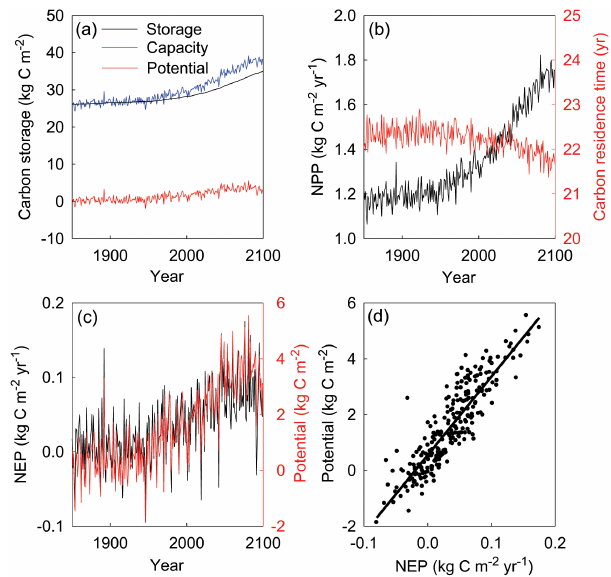
Figure 5. Transient dynamics of ecosystem C storage in response to global change in Harvard Forest. Panel (a) shows the time courses of the ecosystem C storage capacity, the ecosystem C storage po- tential, and ecosystem C storage (i.e., C stock) from 1850 to 2100. Panel (b) shows time courses of NPP( t ) as C input and ecosystem residence times. Panel (c) shows correlated changes in ecosystem C storage potential and net ecosystem production (NEP). Panel (d) illustrates the regression between the C storage potential and